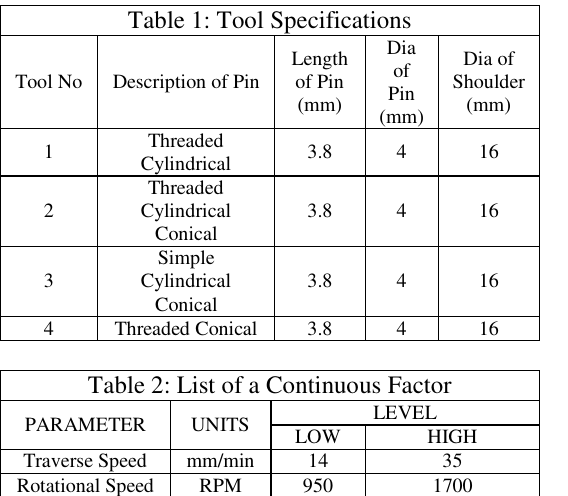
Table 2: List of a Continuous Factor